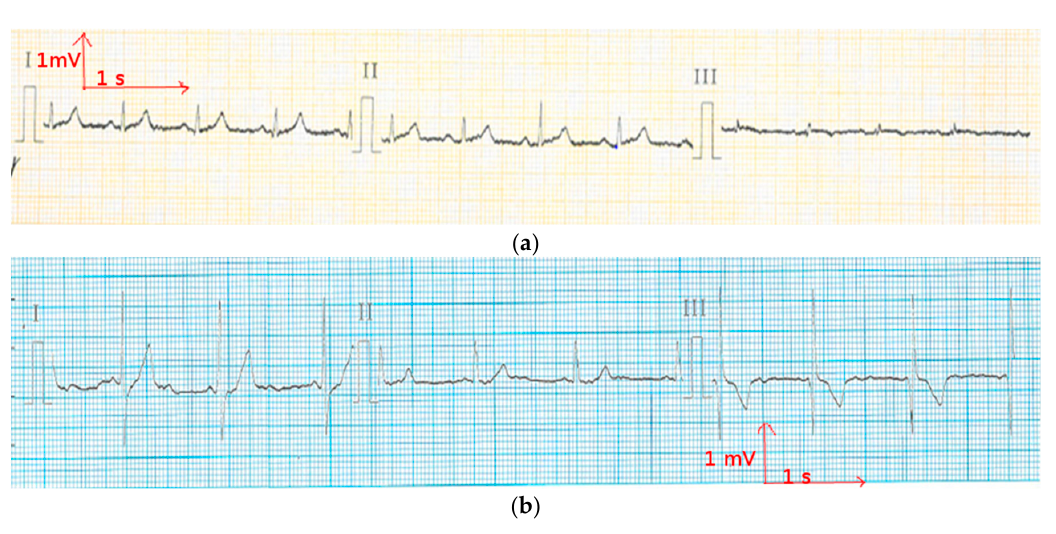
Figure 5. Electrocardiography at rest from the cotton electrode ( a ) before washing, and ( b ) after 50 washing cycles.